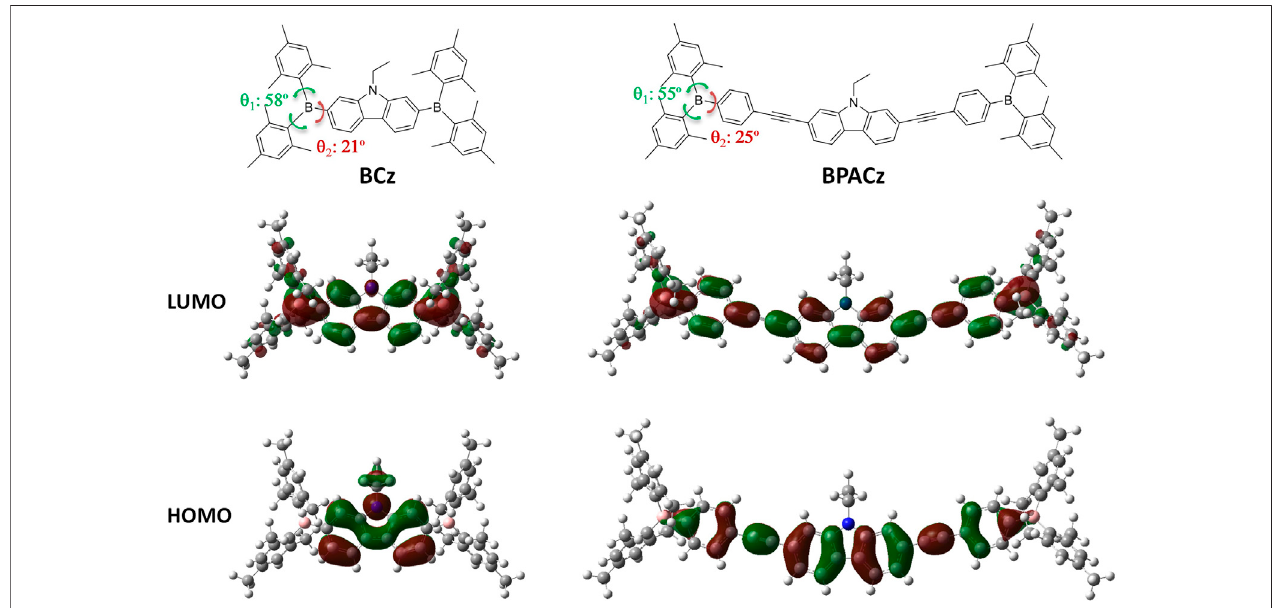
FIGURE 2 | The electron density distribution of the frontier molecular orbitals of the compounds under